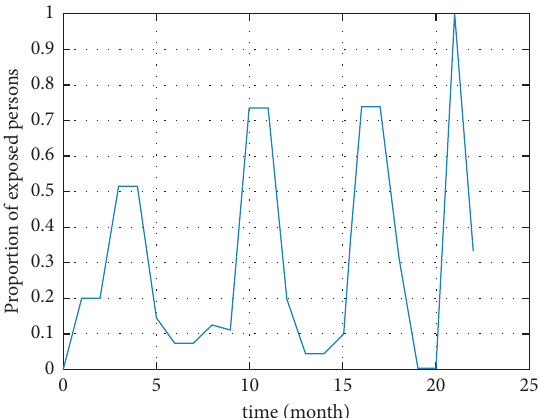
Figure 17: Proportion of the exposed people from March 2020 to January 2022.